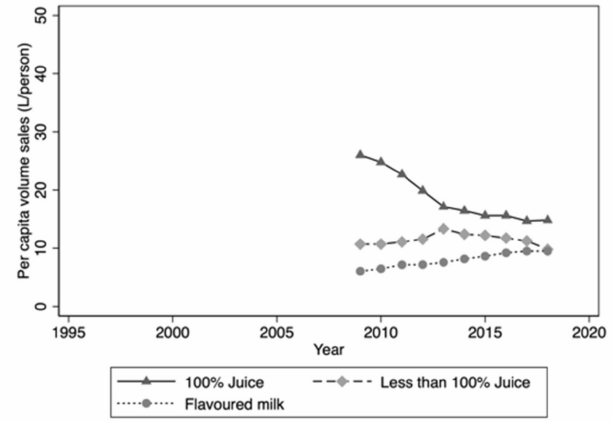
Figure 3. Per capita volume sales: Juice/juice drinks and flavoured milk drinks